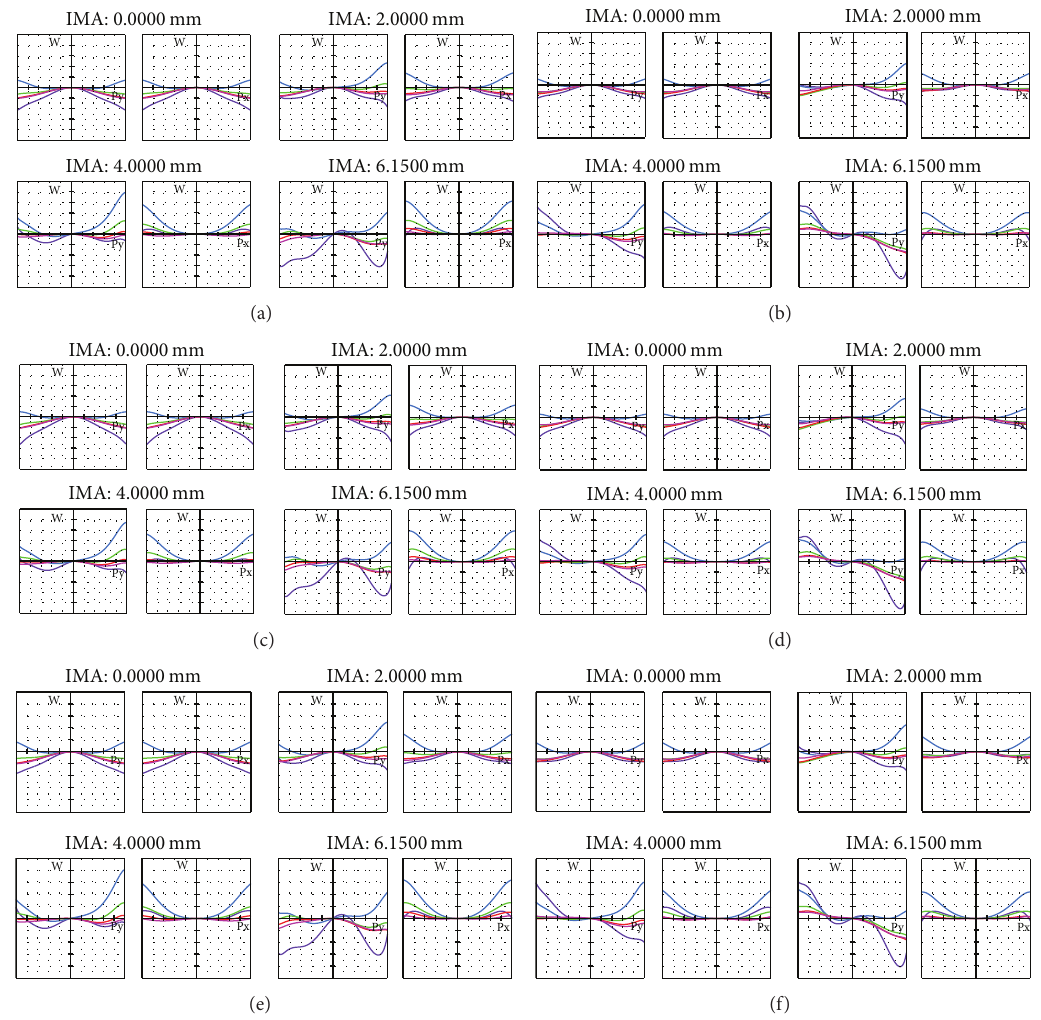
Figure 12: OPD fans: (a) original design at 20 ∘ C, (b) final design at 20 ∘ C, (c) original design at − 20 ∘ C, (d) final design at − 20 ∘ C, (e) original design at 60 ∘ C, and (f) final design at 60 ∘ C. Plot scale is 2